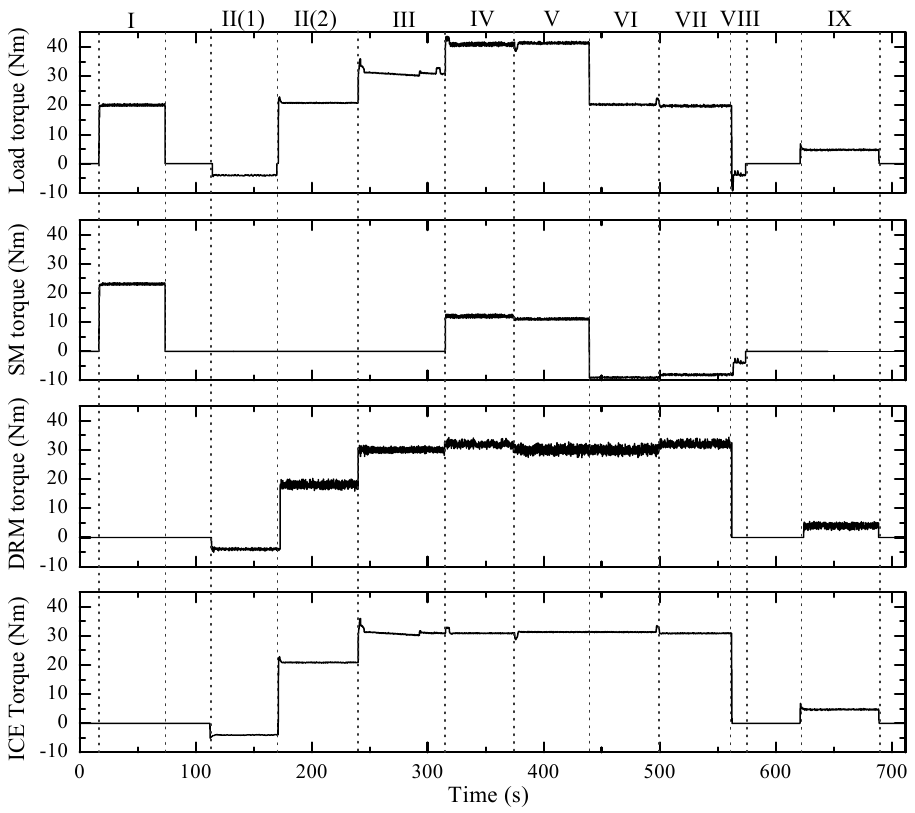
Figure 8. The tested torque curves of the ICE, DRM, SM and load machine.